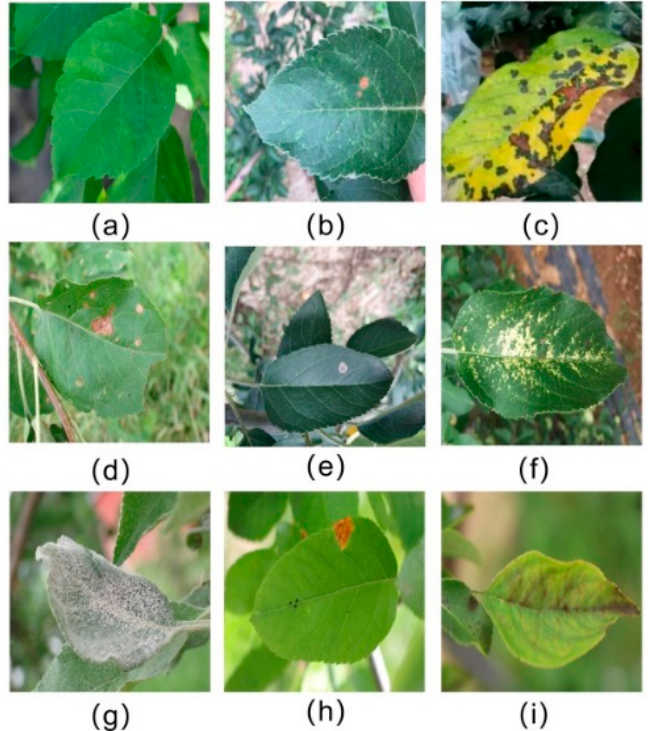
Figure 2. Samples of AppleLeaf9: ( a ) healthy; ( b ) Alternaria leaf spot; ( c ) brown spot; ( d ) frogeye leaf spot; ( e ) grey spot; ( f ) mosaic; ( g ) powdery mildew; ( h ) rust; ( i ) scab.